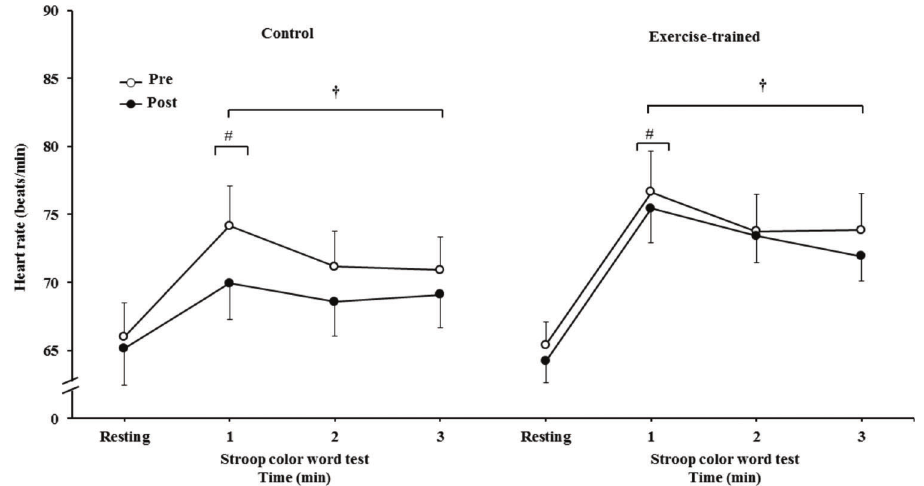
Figure 5A - Heart rate at rest and during the SCWT. w = versus rest, p o 0.05 (within group in pre and post intervention/control); # = versus second and third min of the SCWT p o 0.05 (within group in within group in pre and post intervention/control). Values are mean ± SD. SCWT = Stroop Color Word Test